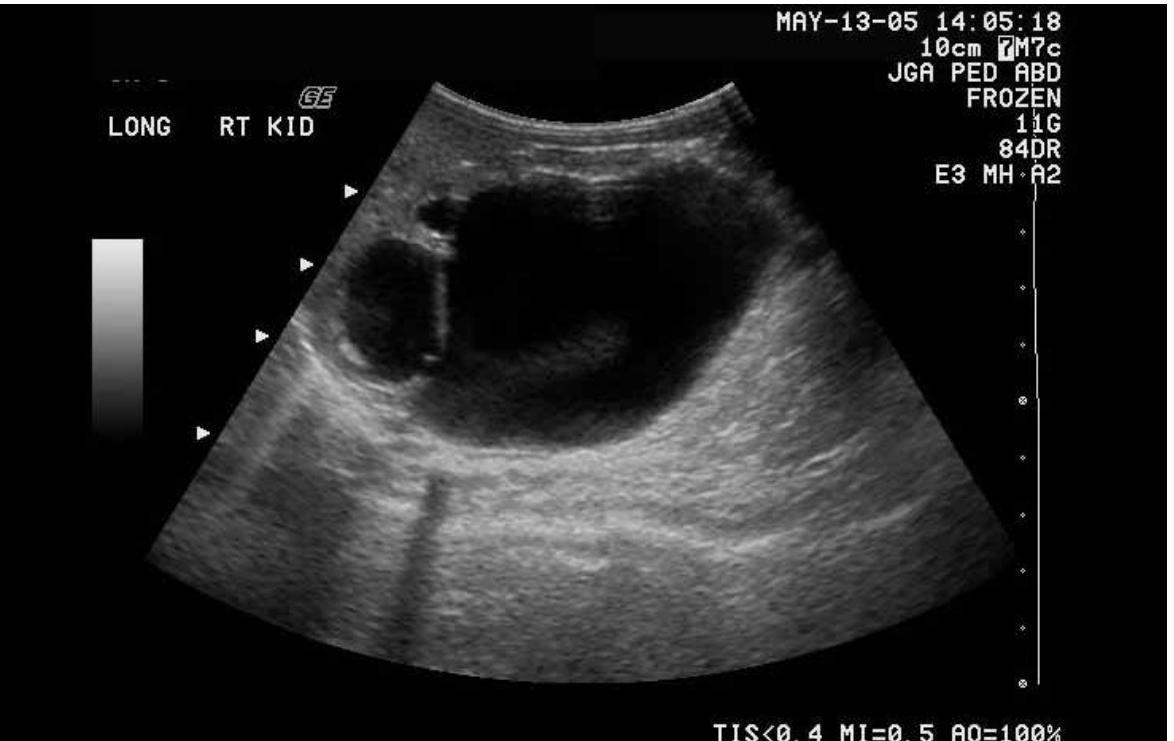
FIGURE 4D . Ultrasound demonstrating renal pelvis and calyceal distention with parenchymal thinning (SFU grade 4).